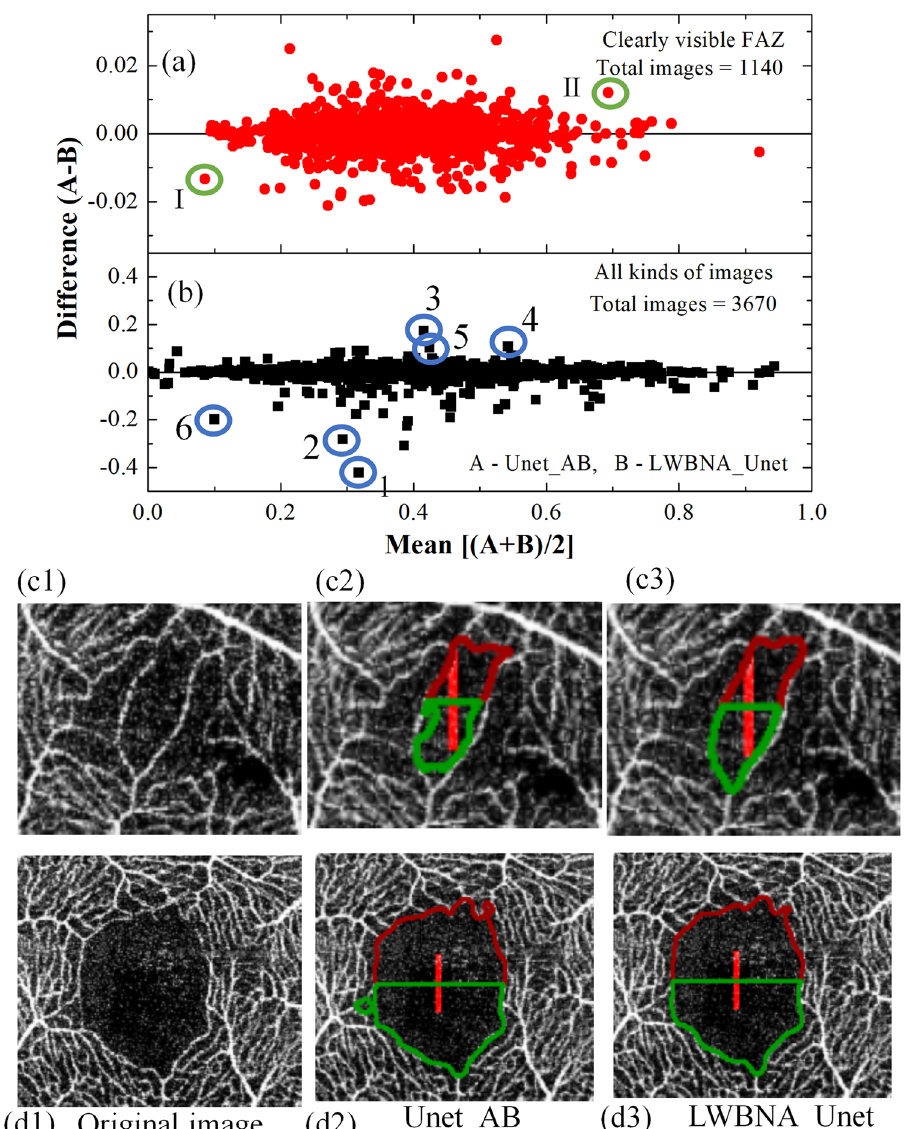
Figure 5. Bland Altman plot of FAZ area measured by the DL models Unet_AB and LWBNA_Unet for ( a ) visually clear 1160, and ( b ) 3670 OCTA images. ( c1 ) is the OCTA image cropped around the center of FAZ, whose area is marked with a green circle I (i.e., smaller size FAZ) in ( a ). Segmentation of FAZ boundary by the models Unet_AB and LWBNA_Unet are shown in ( c1 ) and ( c2 ), respectively. Similarly, the ( d1 ) to ( d3 ) corresponds to the point marked with green circle II ( a ) (i.e., the image with a larger size of FAZ). A careful observation of FAZ boundaries revealed that the segmentation is most accurate for the lightweight DL model developed in this study i.e., ( c3 ) and ( d3